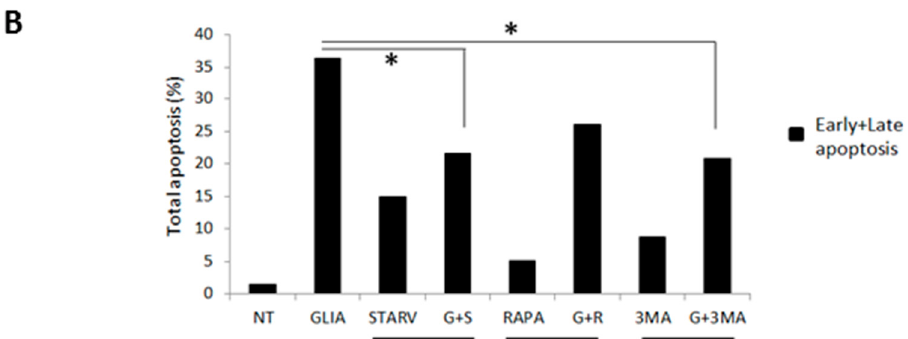
Figure 13. Apoptotic analysis of Caco-2 cells after PT-gliadin administration and